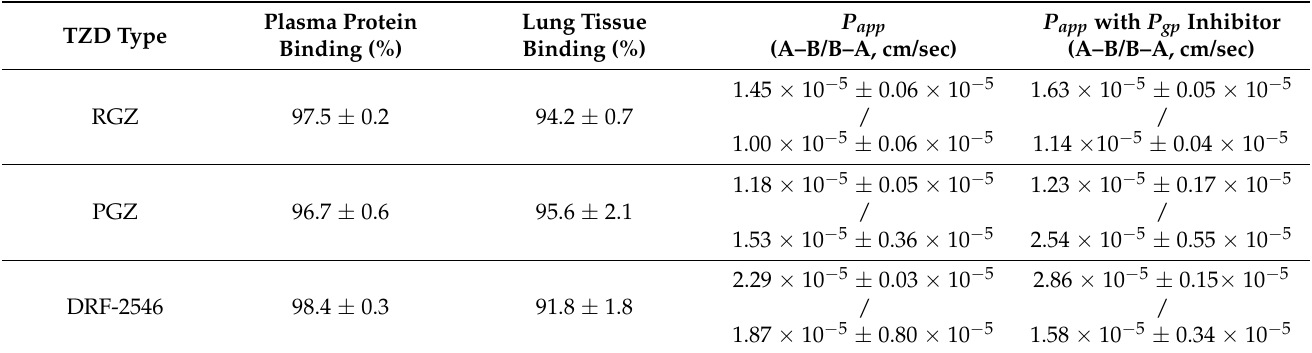
Table 1. Plasma protein binding, lung tissue binding, and apparent permeability through Caco-2 cell monolayers of thiazolidinediones.